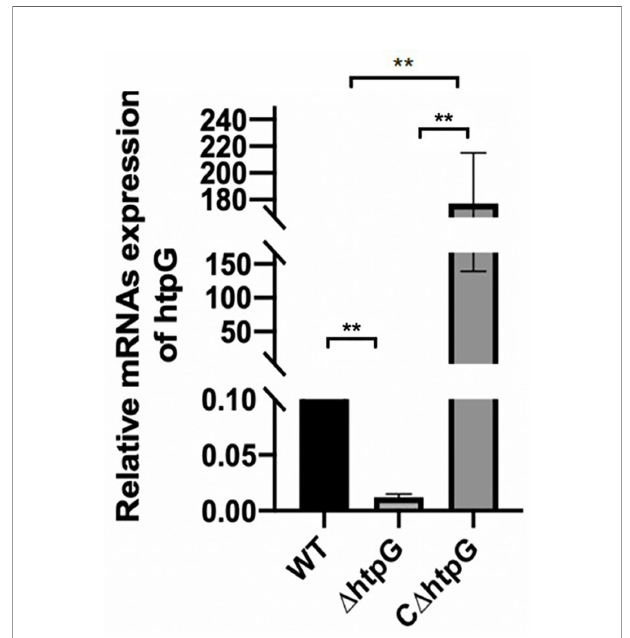
FIGURE 1 | Relative expression level of HtpG mRNA of wild-type strains WT, mutant strains D htpG, and complemented strains C D htpG; the result is shown as the mean ± standard error, ** means p < 0.01, n =